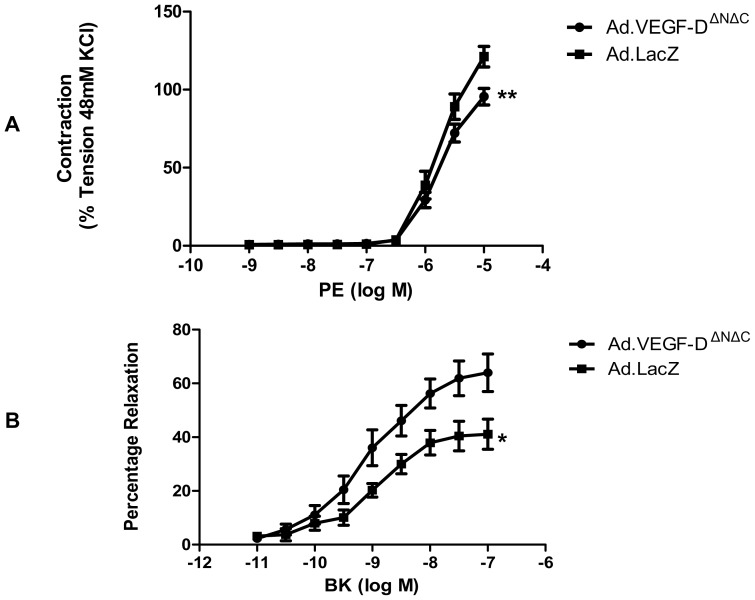
Vascular reactivity of uterine arteries 4–7 days after vector administration.(A) Logarithmic dose-response curve to L-phenylephrine (PE) depicting that the contractile tension generated in the UtAs of pregnant sheep (n = 6) is significantly lower in Ad.VEGF-DΔNΔC transduced vessels relative to Ad.LacZ transduced vessels 4–7 days post-vector injection. The contractility of the vessel is expressed as a percentage of the response to KCl. ** p<0.005. (B) Logarithmic dose-response curve to Bradykinin (BK) depicting that the relaxation response generated in the UtAs of pregnant sheep (n = 5) is significantly greater in the Ad.VEGF-DΔNΔC transduced arteries compared to Ad.LacZ treated vessels 4–7 days post-vector injection. The relaxation is expressed as a percentage of inhibition of PE-induced contractions. * denotes p = 0.05. Error bars denote SEM.